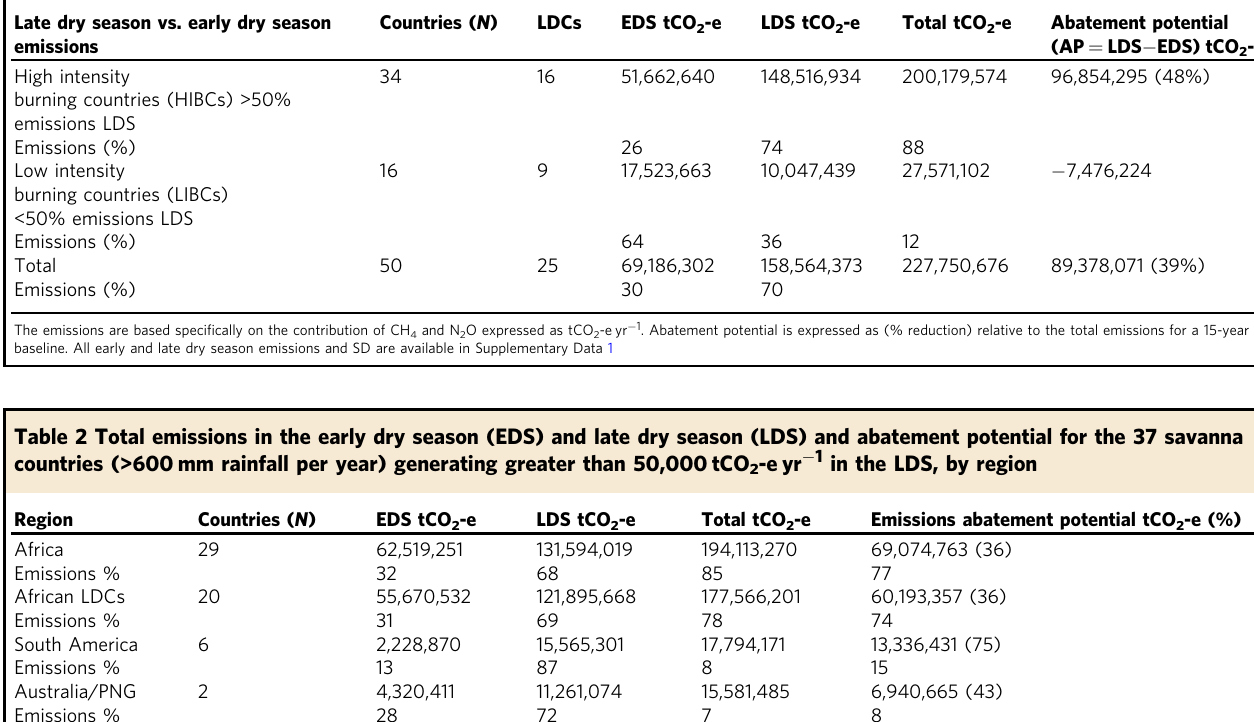
Table 1 Total emissions for late (>50% emissions LDS) and early (<50% emissions LDS) burning savanna countries (for all 50 countries >600 mm rainfall per year)